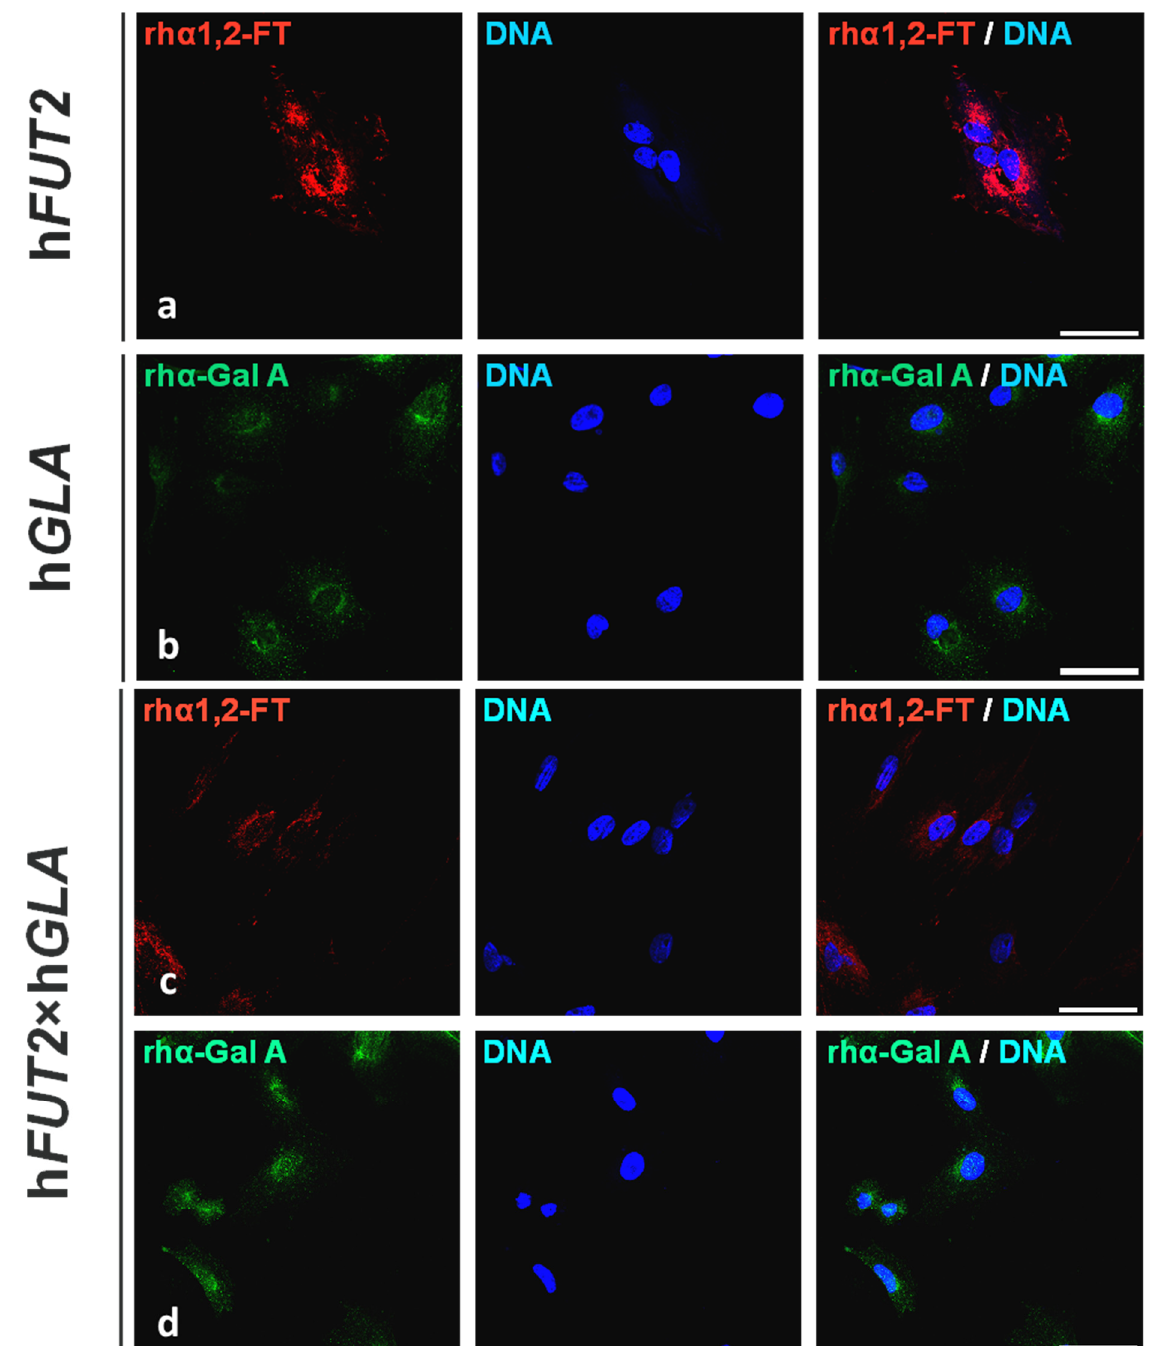
Figure 1. Immunofluorescence analysis of ex vivo-expanded PEKs originating from different variants of genetically en- gineered pigs detailed as: h FUT2 mono-transgenic ( a ), h GLA mono-transgenic ( b ) and h FUT2 × h GLA bi-transgenic ( c , d ). Representative microphotographs depicting immunofluorescent detection of rh α 1,2-FT-related ( a , c ) and rh α -Gal A-related ( b , d ) locations recognized in single- and double-transgenic PEKs, respectively. Immunostaining with aid of red Cy3 fluorochrome-tagged or green Alexa Fluor 488 fluorochrome-tagged secondary antibodies and blue fluorescent nuclear counterdyeing with use of 4 (cid:48) ,6-diamidino-2-phenylindole (DAPI). Scale bars represent 50 µ m. Centers of immunofluores- cently labelling the rh α 1,2-FT enzymes were primarily localized in the perinuclear region of all analyzed cells ( a , c ). rh α -Gal A-descended signaling points were found to be homogeneously distributed in whole cytoplasm of diagnosed cells from each transgenic variant ( b , d